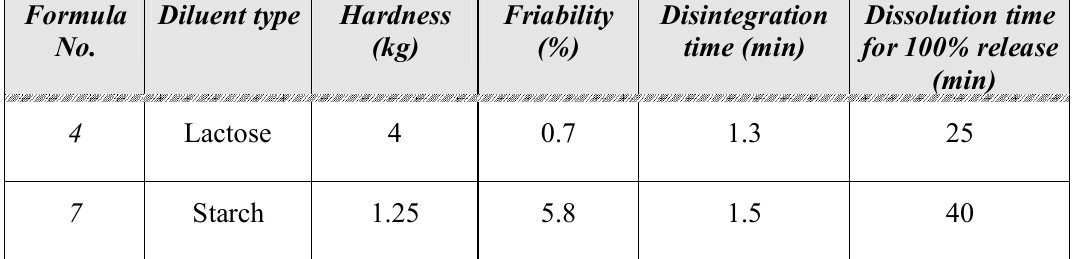
Table (4): The effect of diluent on the physical properties of captopril tablet and the release of captopril from suggested formulas 4 and